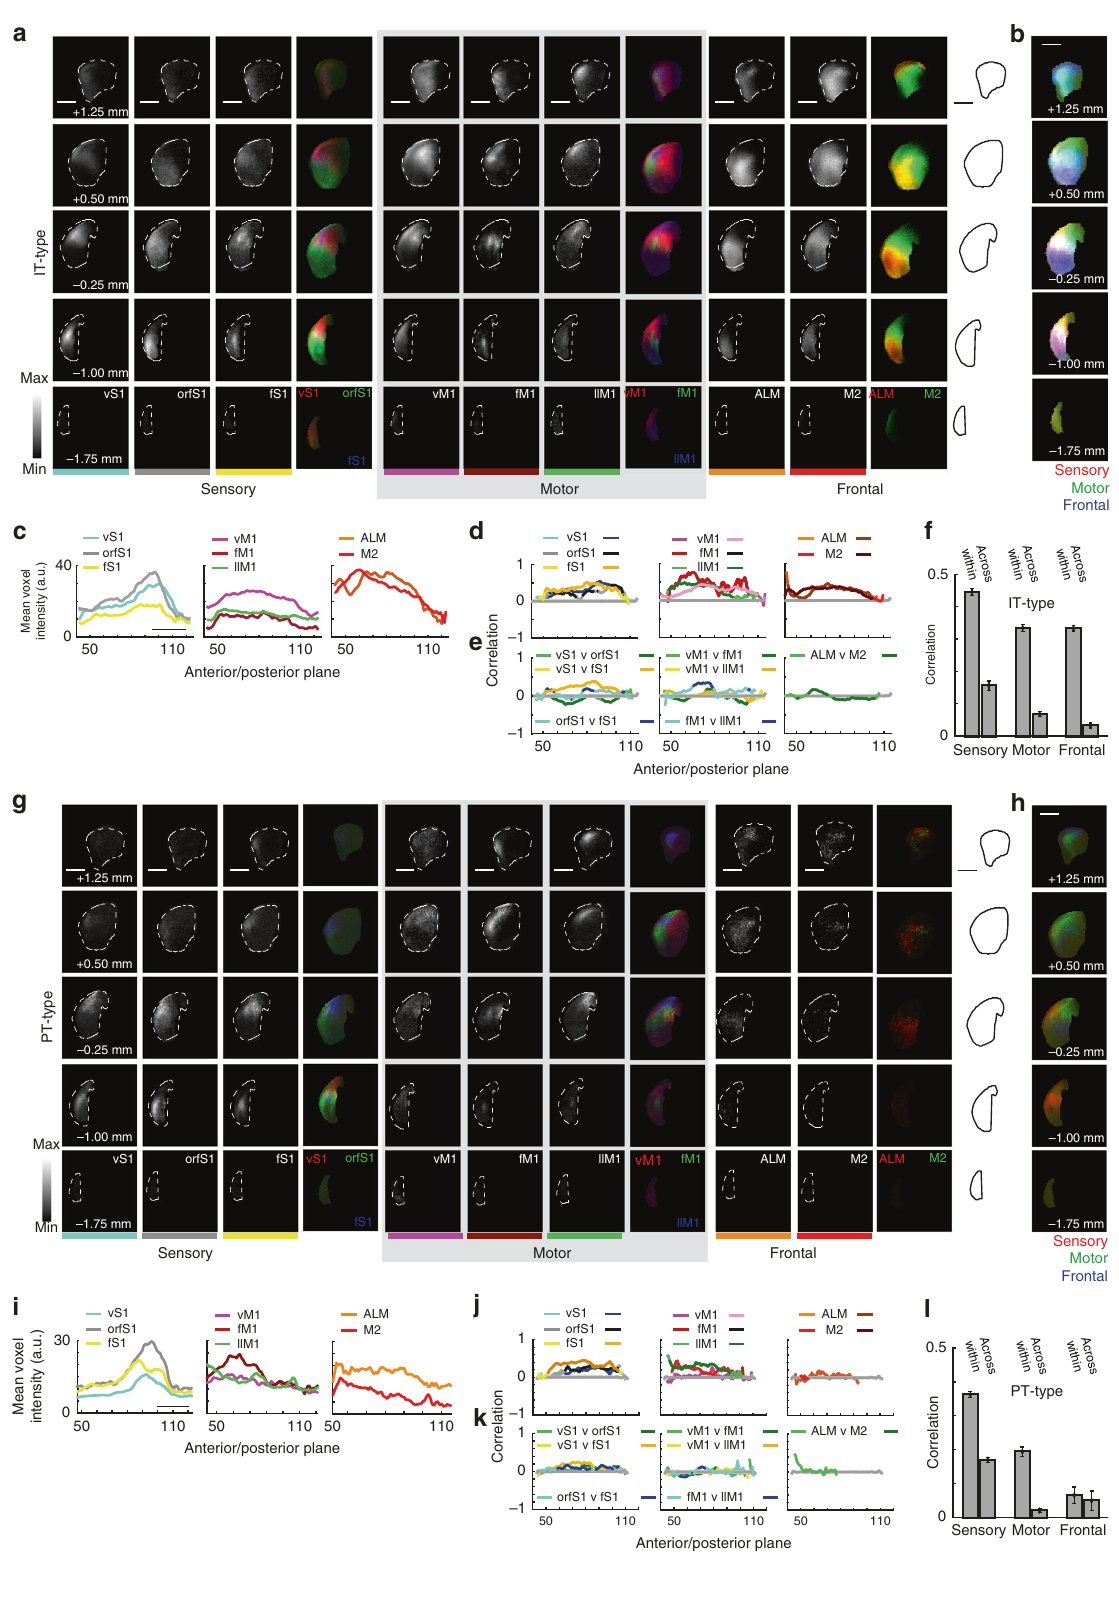
However, the correlation versus distance relationship was similar to that of the within PT-type injection comparisons (Fig. 4f) while the number of overlapping voxels was intermediate to IT – IT and PT – PT comparisons (Fig. 4e). Corticostriatal projections of both types tended to target the same striatal regions for a given cortical